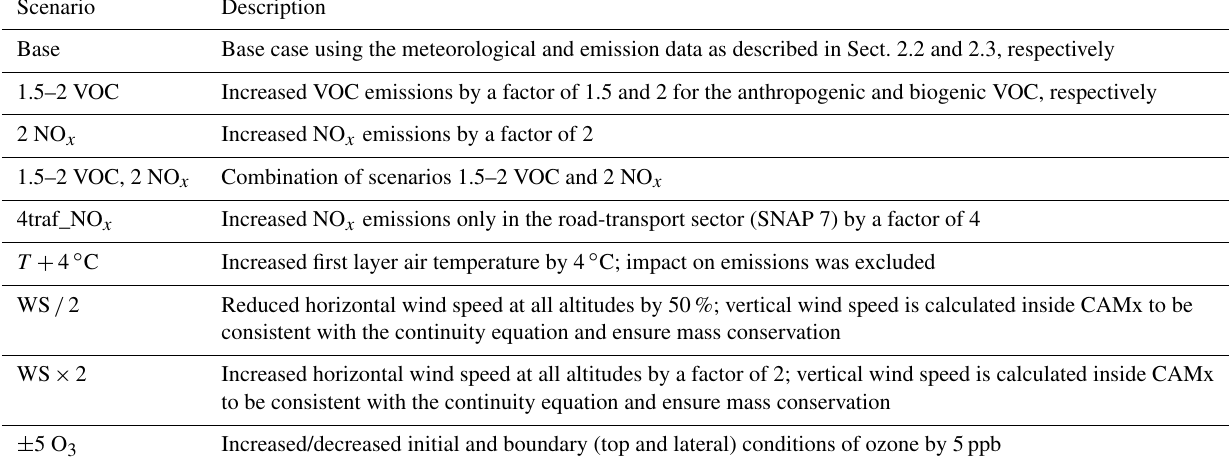
Table 3. Description of sensitivity tests. Scenario